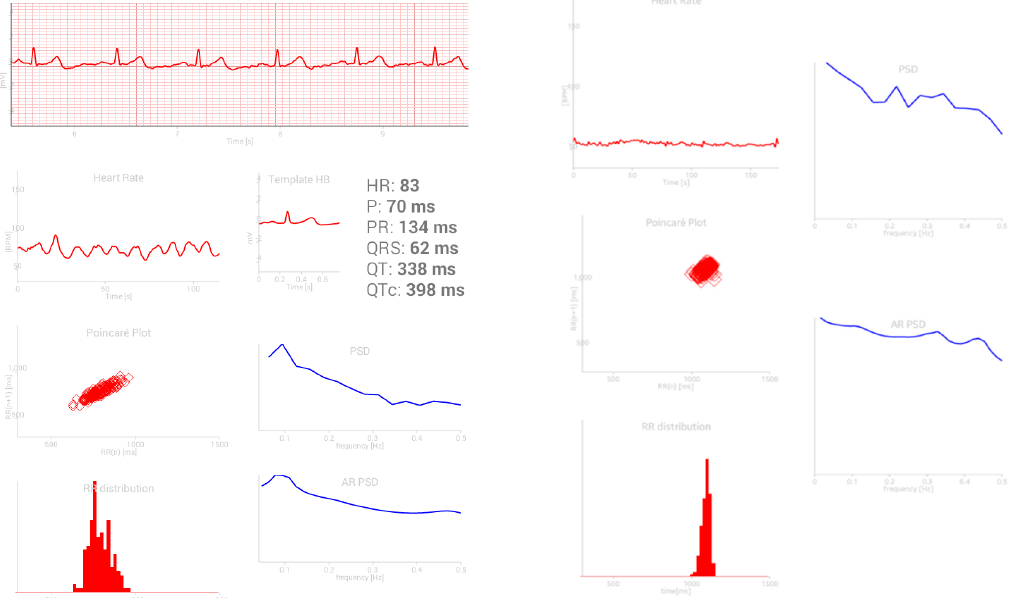
Figure 5. ECG for Everybody, an Android application available at [30]-a printout summary of a signal (lengths up to 120 s); the ECG signal is stored in database, while the participant, at his/her mobile device, can observe Poincaré plots.